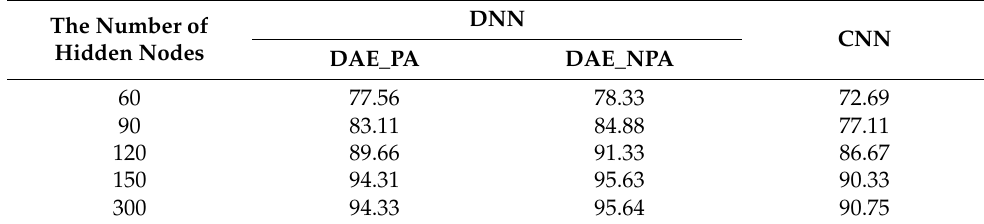
Table 4. The recognition rates (%) of DNN and CNN.